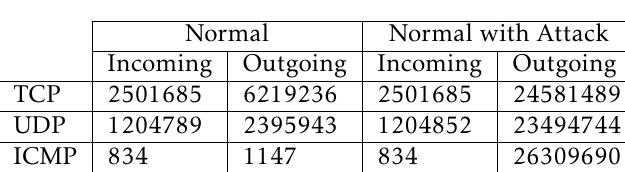
Table 5. Number of incoming and outgoing packets for different